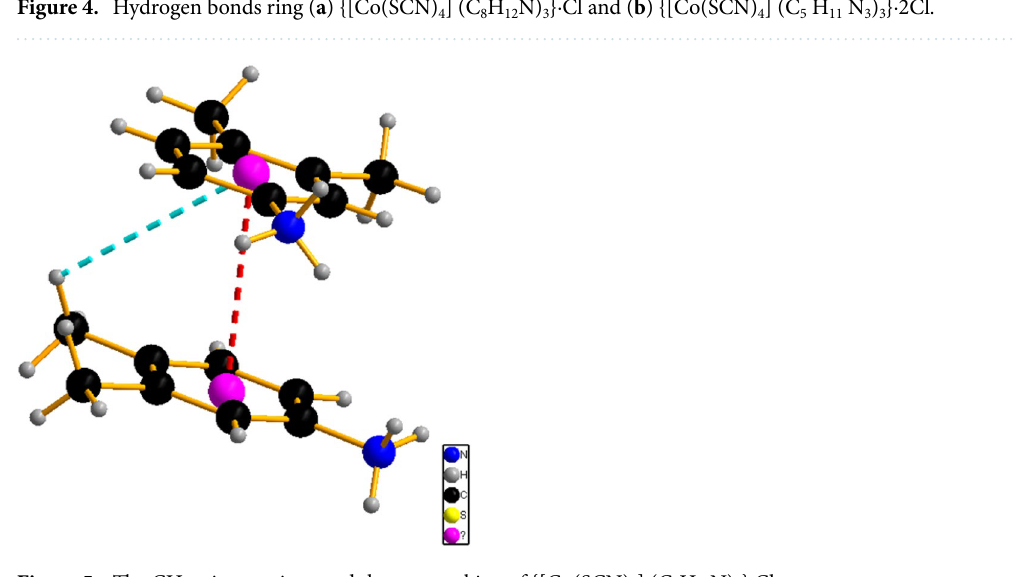
Figure 5. The CH–π interactions and the π-π stacking of {[Co(SCN) 4 ] (C 8 H 12 N) 3